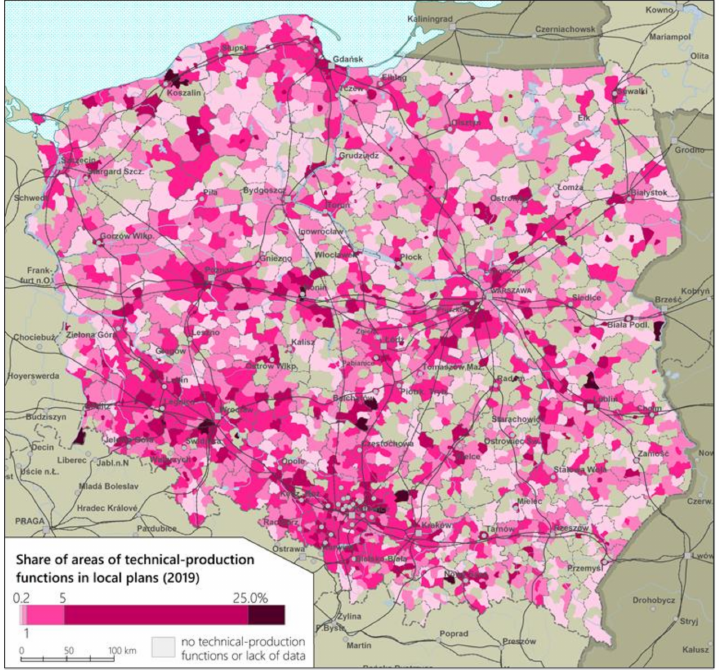
Figure 3. Share of the area of communes allocated to production functions in the spatial development local plans (local plans), for the year 2019 (relating to the area of communes). Source: based on data from the Ministry of Development and Central Statistical Office of